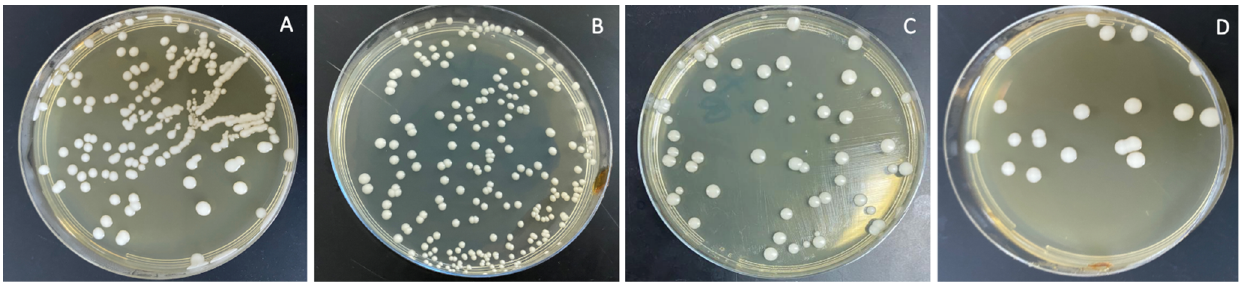
Figure 8. Cultures of Candida albicans colonies in AP/PMMA in ( A ) pure PMMA, ( B ) 0.1%, ( C ) 0.25%, and ( D ) 0.5% ND.